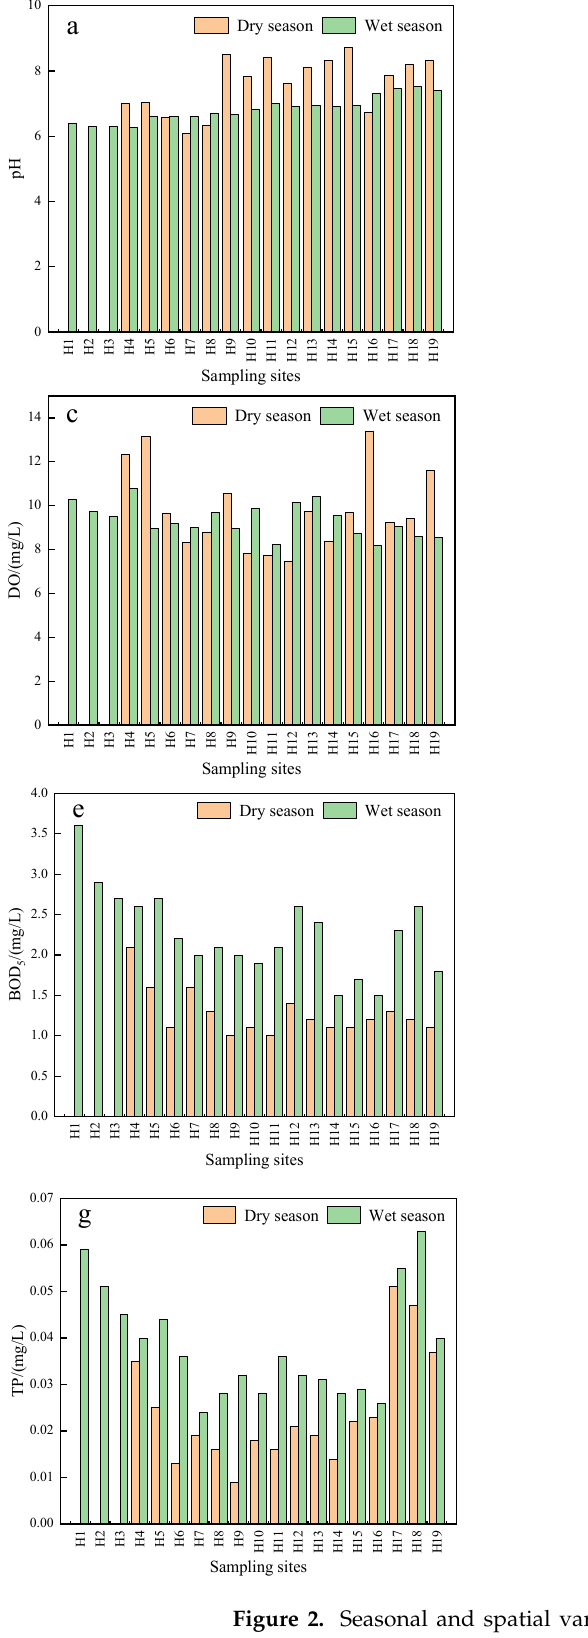
DO and BOD 5 concentrations as well as pH values during the dry and wet seasons met the level Ⅰ water standard; both NH 3 -N and TP concentrations during the dry and wet seasons met the level Ⅱ water standard; and COD Mn concentrations during the dry and wet seasons met the level Ⅲ and Ⅳ water standards, respectively. Notably, COD Mn con- centrations during the wet season were unnaturally high and did not satisfy the level Ⅲ water standard for potable water.